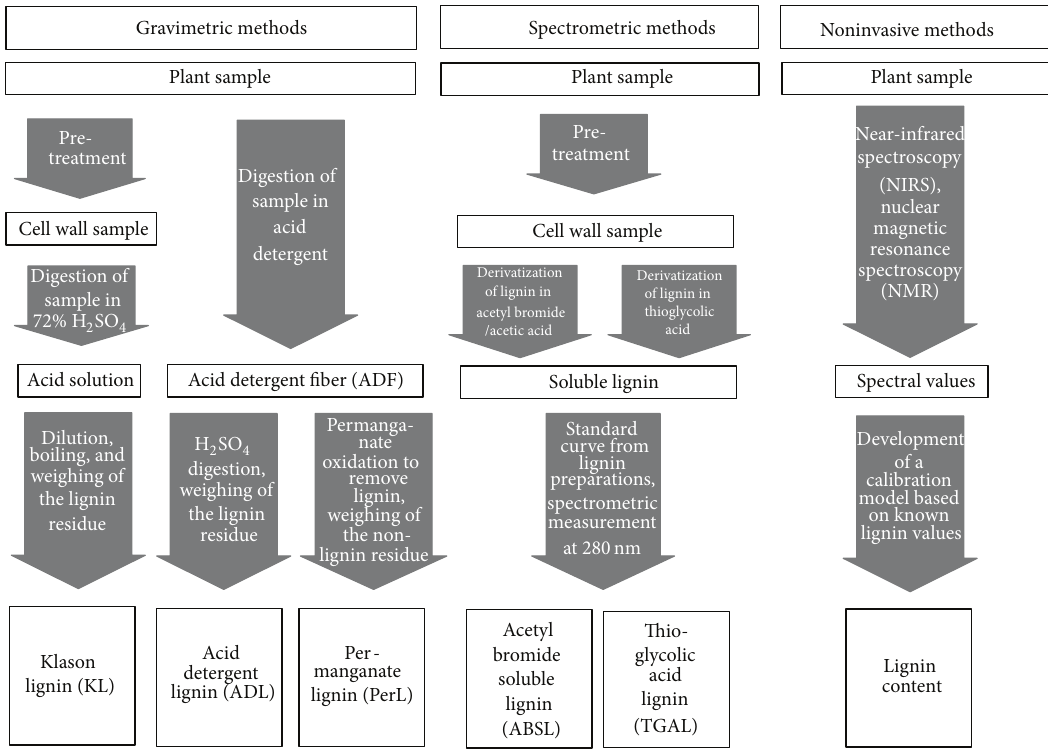
Figure 2: Overview of different lignin analysis